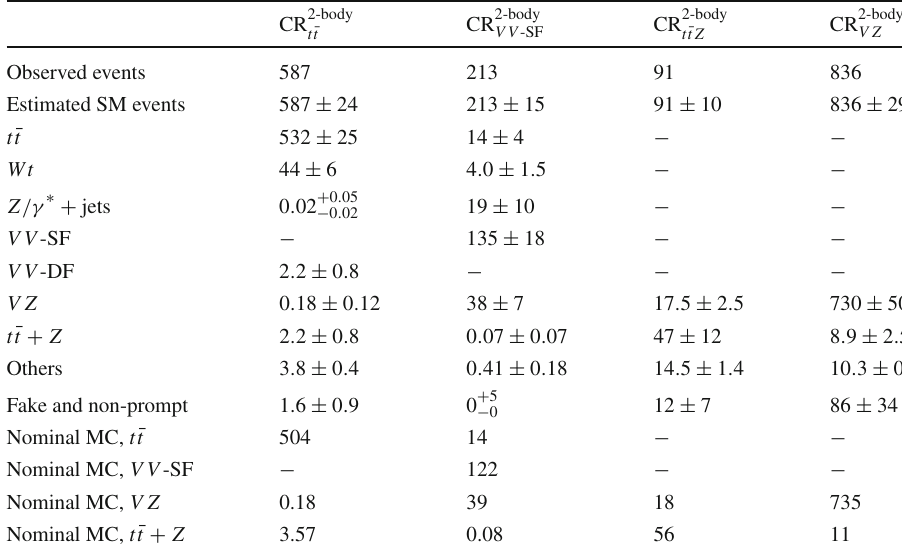
Table 7 Two-body selection background fit results for the CRs of the SRA 2-body and 180